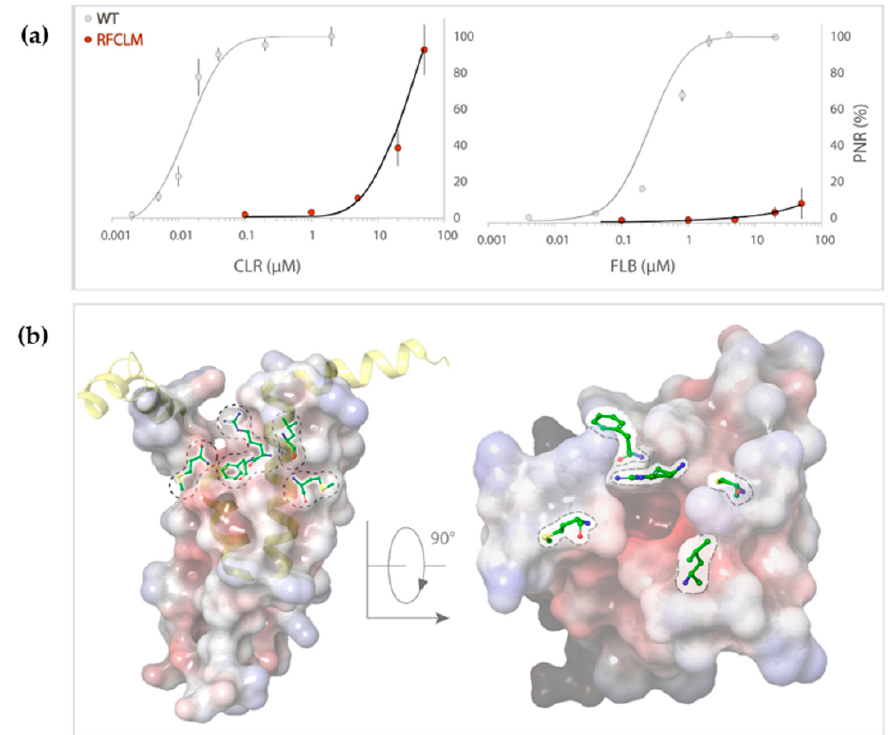
Figure 4. ( a ) RFCLM-PxRyR is only activated by CLR at very high concentrations (>10 µM) but is not activated by FLB at its limit of solubility. Graphs display the dose–response relationship of RFCLM-PxRyR (red fill) to CLR and FLB (with WT PxRyR (grey fill) response for comparison). CLR- and FLB-induced Ca 2+ release was normalised to the maximal caffeine-evoked Ca 2+ release in the same cells to calculate the proportional normalised response (PNR), which is presented here as % maximum PNR. ( b ) PxRyR-rRyR1 homology model of the RFCLM-PxRyR pVSD, displayed in (i) longitudinal and (ii) transverse orientation. Positions of the five amino acid substitutions are marked; dotted lines indicate that the residue is hidden within the structure. The homology model was generated using Pymol and Schrodinger